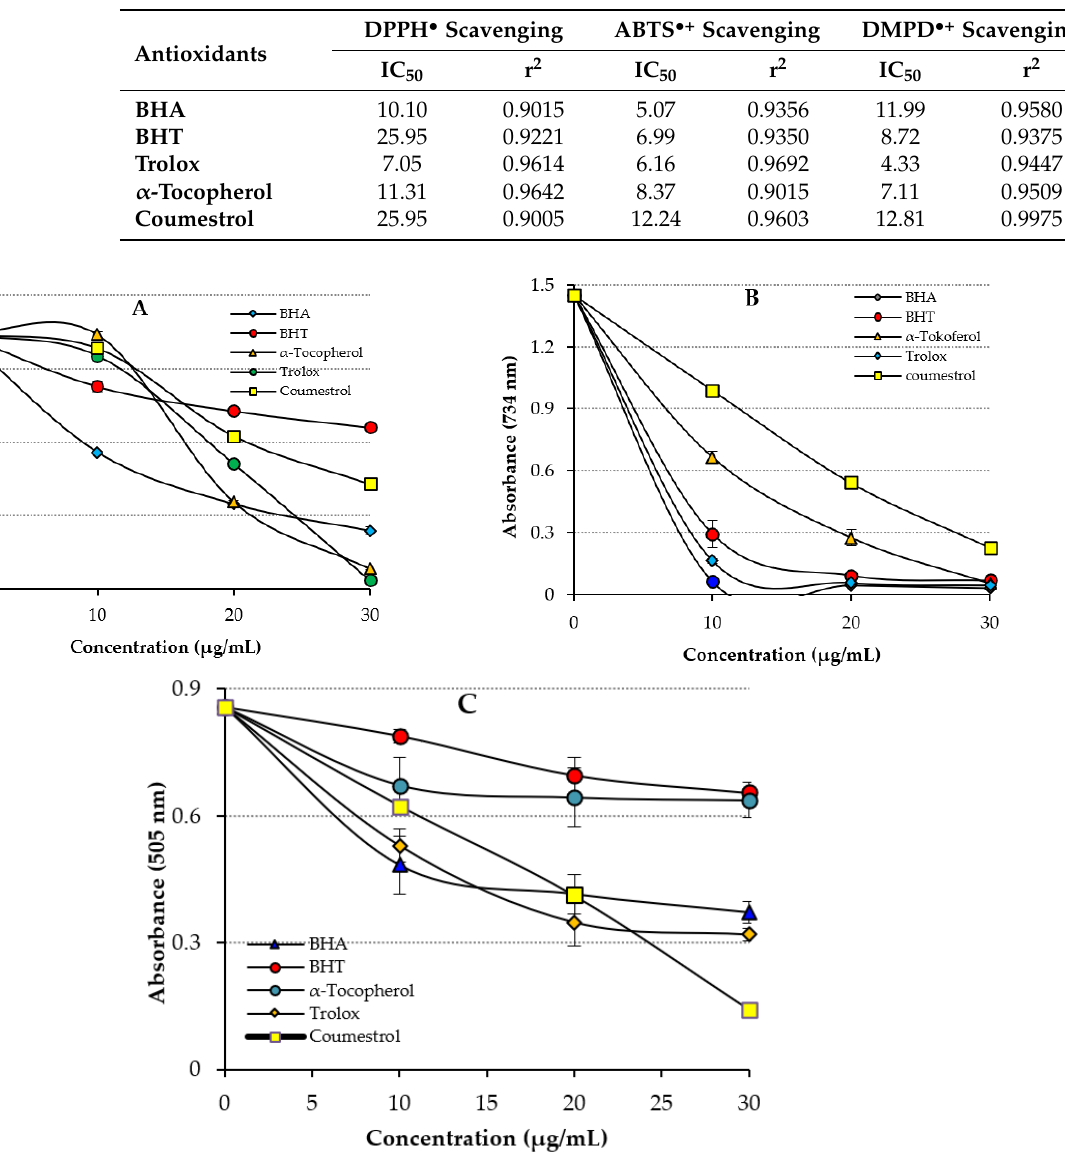
Table 2. IC 50 ( μ g/mL) values for DPPH • ‐ , ABTS •+ ‐ and DMPD •+ ‐ scavenging activities of Coumestrol and of standard antioxidants. Table 2. IC 50 ( µ g/mL) values for DPPH • -, ABTS • + - and DMPD • + -scavenging activities of Coumestrol and of standard antioxidants.